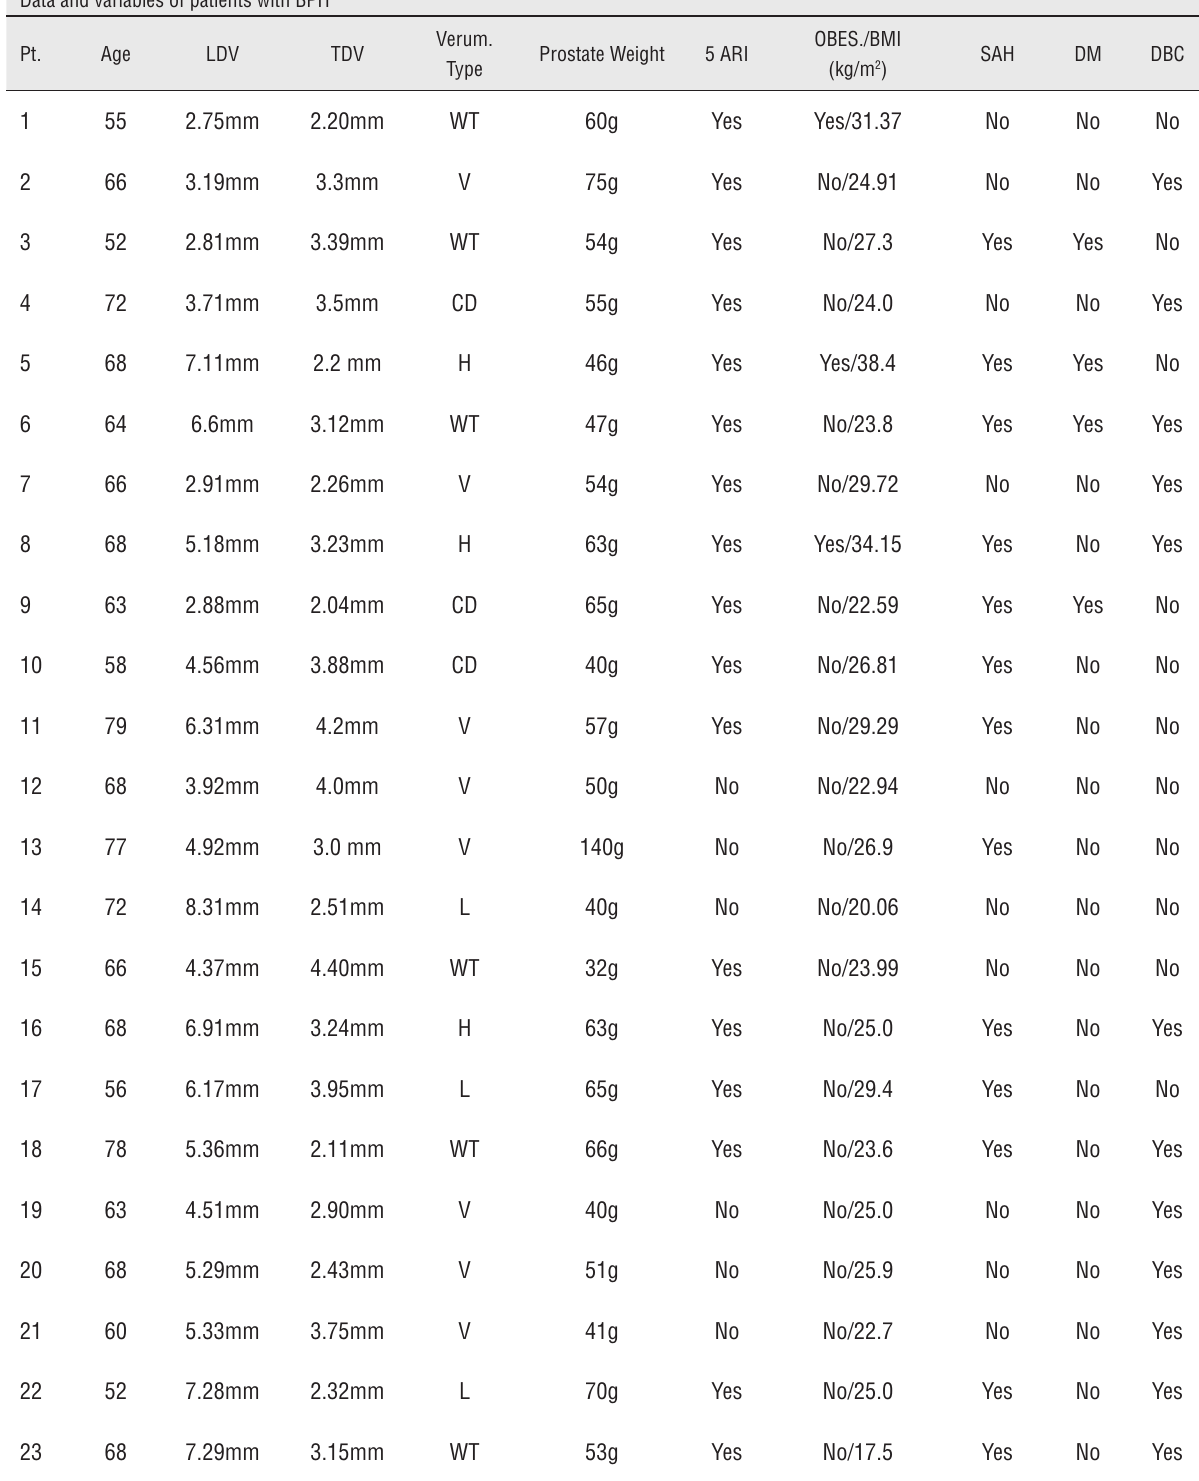
Table 1 - All data and variables of all patients. Data and variables of patients with